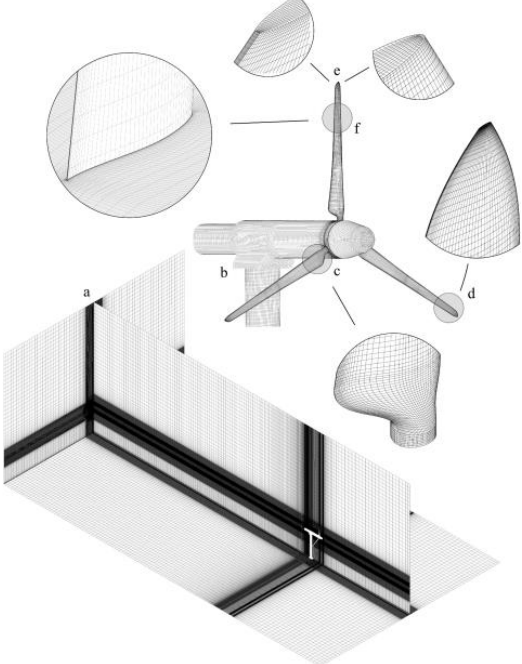
Figure 5. Computational domain: ( a ) structured multiblock hexahedral mesh; ( b ) complete wind turbine (blades, hub, nacelle, and tower); ( c ) root of the blade; ( d ) tip of the blade; ( e ) trailing and leading edge at the tip; ( f ) boundary layer [51]. Reproduced with permission from Regodeseve et al., Energy; published by Elsevier, 2020.